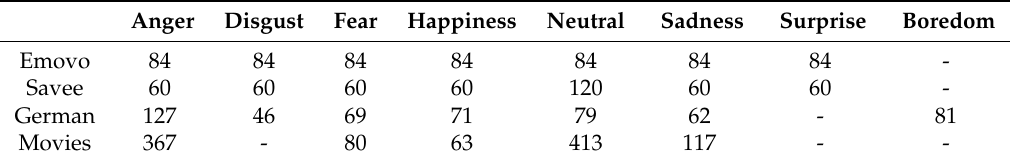
Table 1. Number of Audio of the Original Audio Databases for each